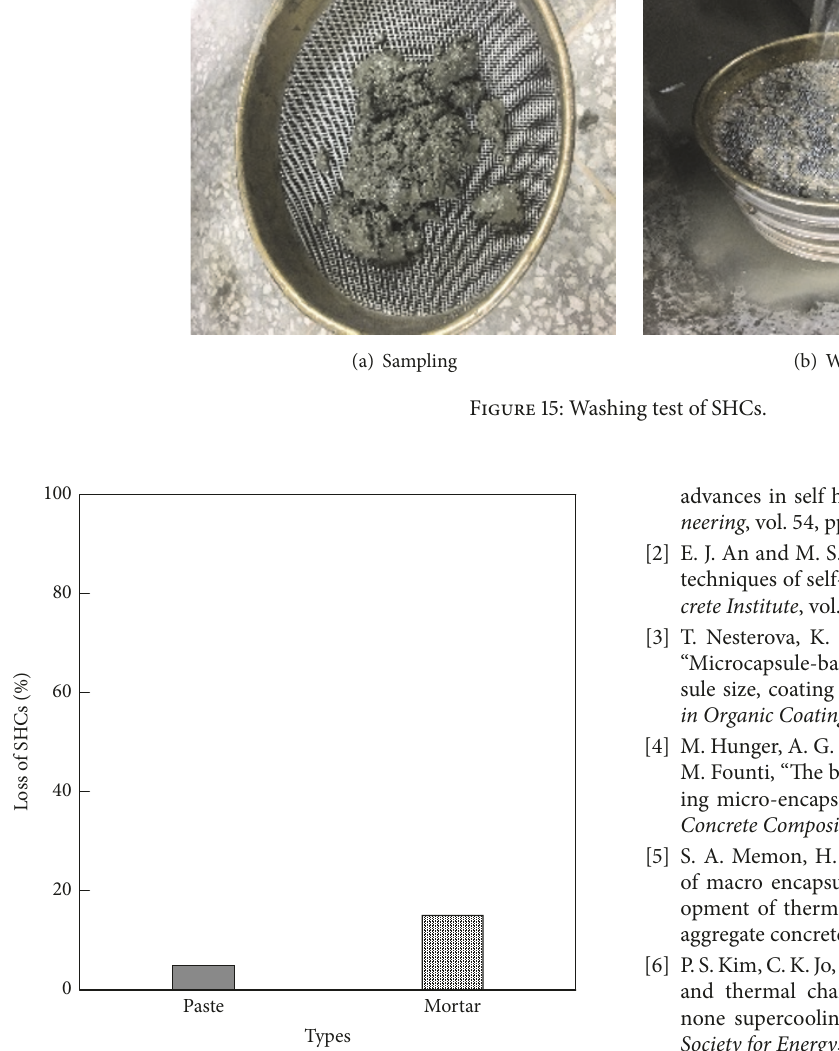
Figure16:LossofSHCsimmediatelyaftermixingwithcementitious